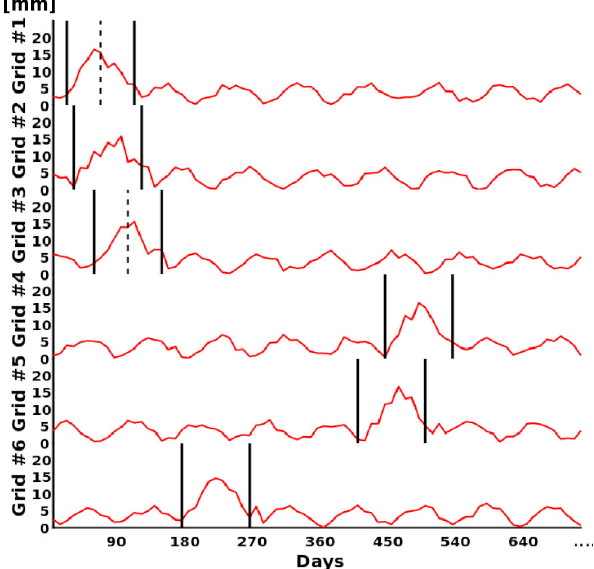
Figure 1. Methodological approach in an idealized one- dimensional grid to identify spatial coherences of extreme seasons. Red lines show precipitation time series per grid point, vertical black lines delineate the identified extreme season per grid point and vertical dotted lines depict their central date (only for two sea- sons, to be used as an example in